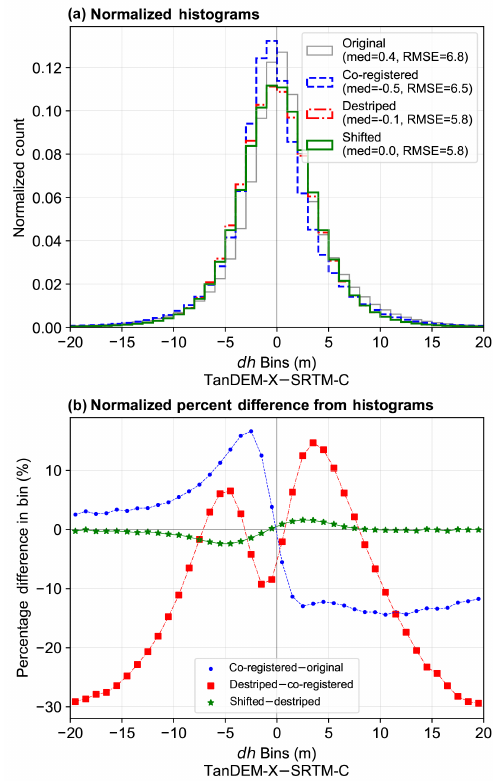
Figure 5. Characteristic (a) stacked histograms and (b) normalized percentage bin difference from three tiles merged and processed (24–26 ◦ S, 66 ◦ W). Though it is difficult to interpret the histograms, plotting their difference (normalized by bin count) as percentage change between successive steps demonstrates the shifting of the median to near zero and the reduction in outliers.